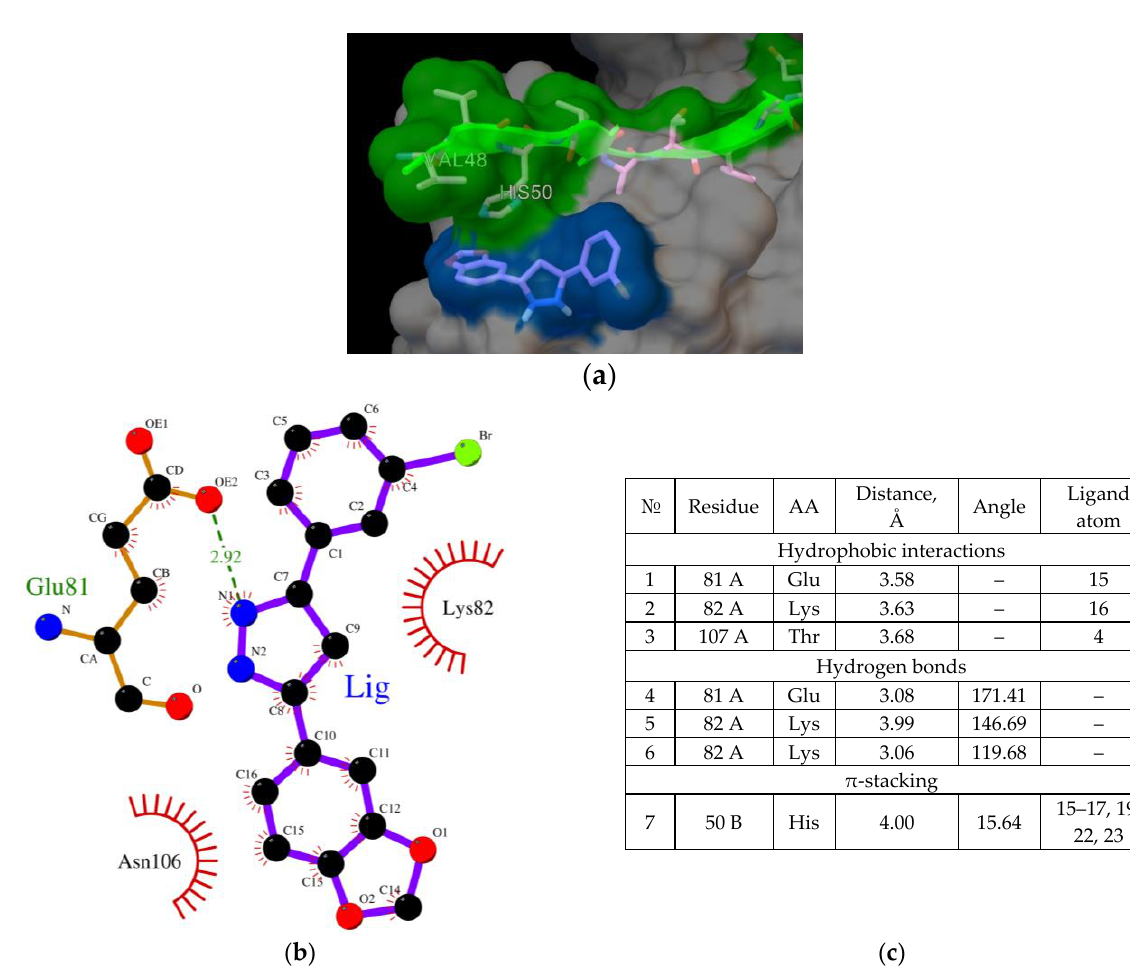
Figure 3. ( a ) Binding of the Anle138b molecule to the AαSyn– CypA complex (PDB ID 6I42), a fragment of the surface of the AαSyn molecule is indicated in green, the surface of the CypA globular protein is indicated in gray, the molecular surface of the Anle138b ligand is indicated in blue; ( b ) chart of interactions upon binding of Anle138b to the AαSyn– CypA complex; ( c ) interactions diagram of Anle138b with AαSyn– CypA complex.